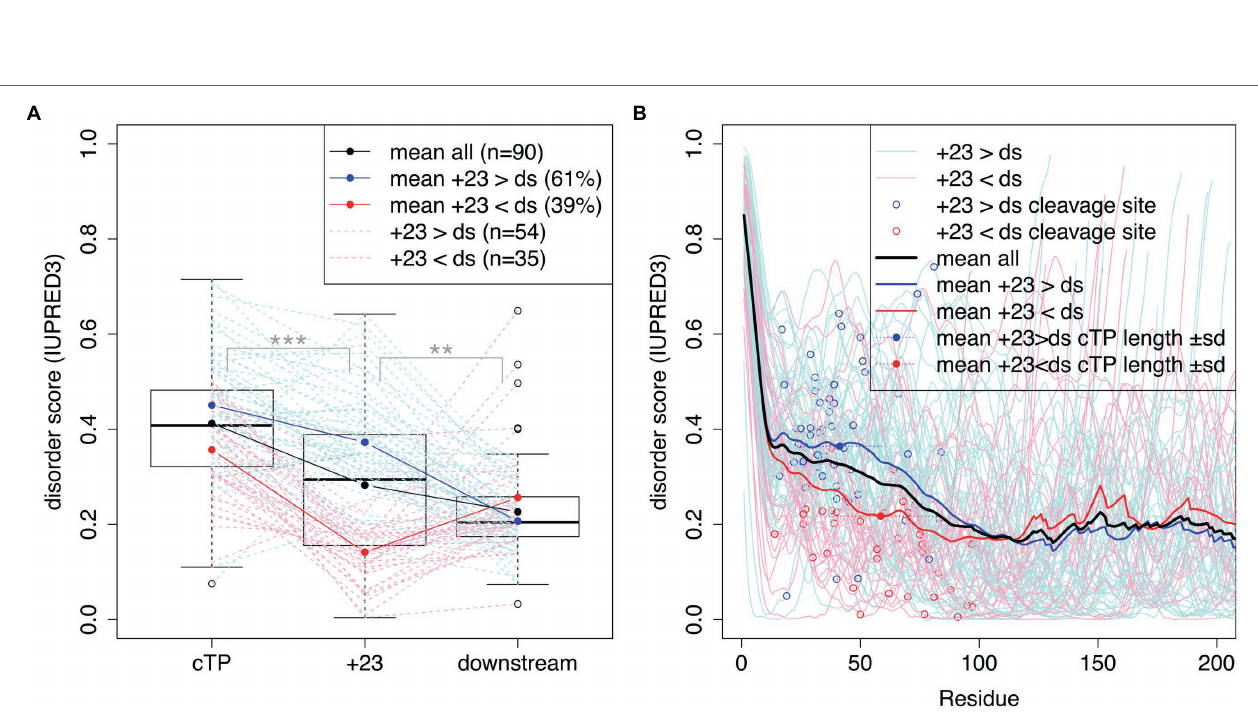
FIGURE 4 | cTPs and post-cleavage site stretches are more disordered than downstream mature protein sequences. Protein disorder profiles of 90 chloroplast- localized, nuclear encoded Chlamydomonas proteins with known cleavage sites were obtained using IUPRED3. Disorder scores can range from 0 to 1 with higher values implying more disorder. (A) Boxplots show the distribution of scores for sequences up to the cleavage site (cTP), the 23 residues following the cleavage site (+23) and mature protein sequences excluding the N-terminal 23 residues (downstream; ds). Statistical significance is shown as *** for p < 0.001 and ** for p < 0.01 (paired t -tests). Values for individual sequences are shown in dashed lines, in blue when the +23 value is higher than the downstream value, or in red otherwise (one case where the sequence past the cleavage site was less than 23 residues long is in shown in gray). (B) Individual and mean disorder profiles along the sequence are shown starting from preprotein N-termini. The position of the cleavage site is highlighted by showing the last cTP residue disorder value as a